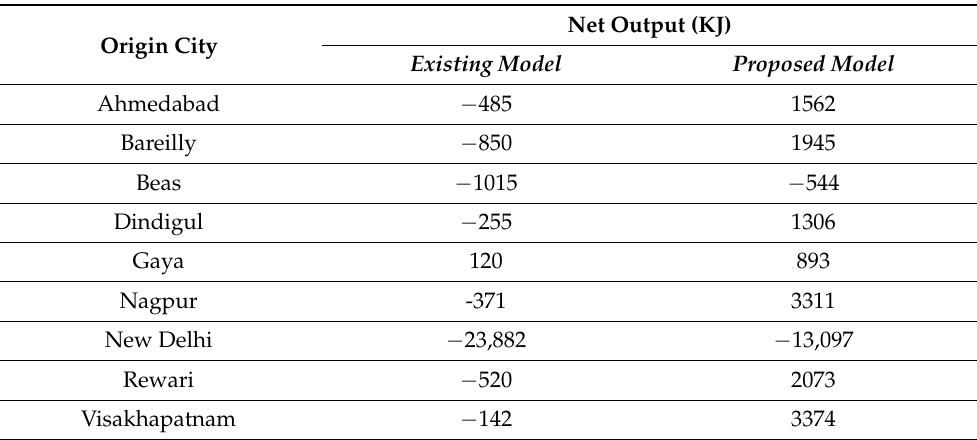
Table 2. Net Output Comparison for Mathematical